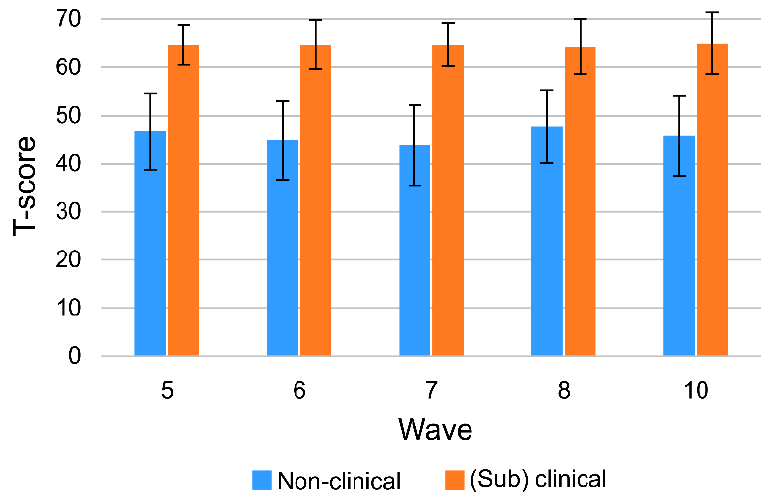
Figure 1. CBCL total problems (T-score).